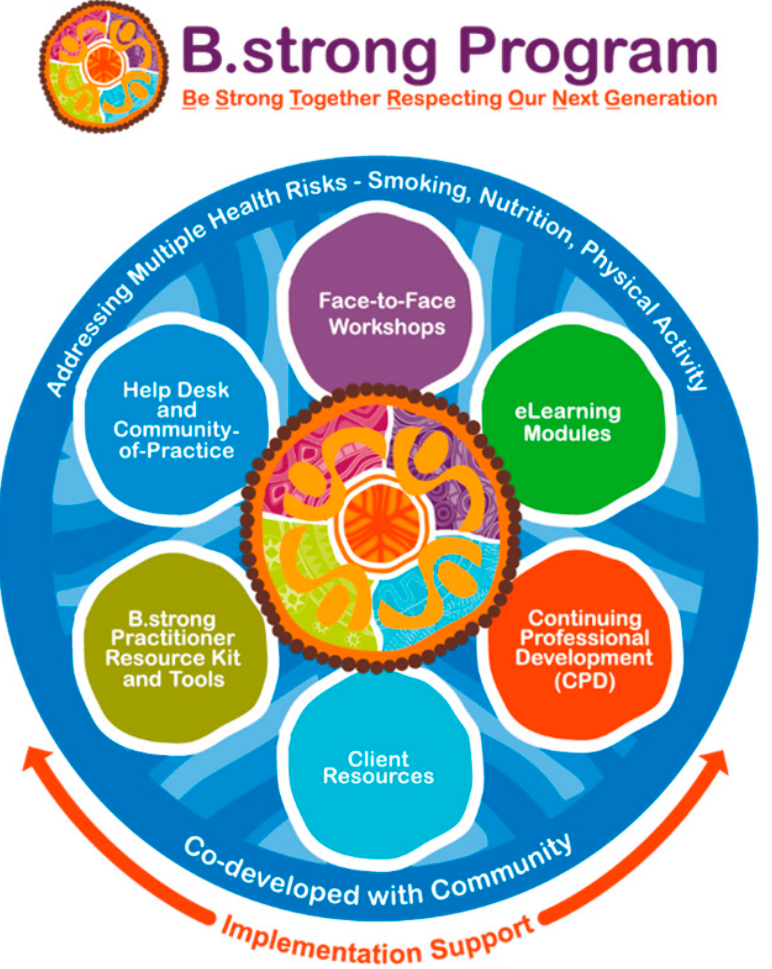
Figure 1. Components of the B.strong program.